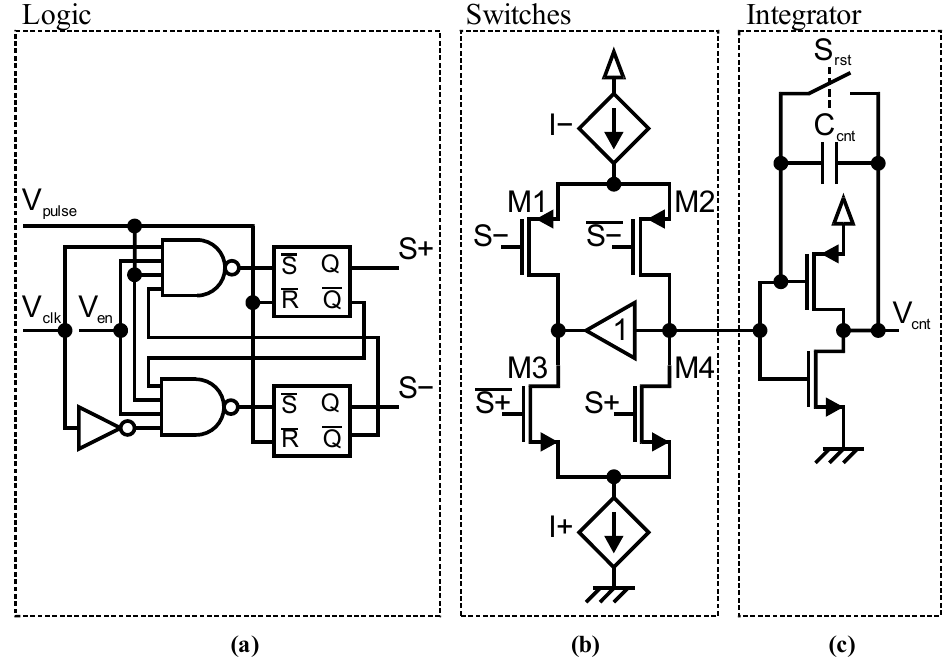
Figure 3. Analog correlator circuit consisting of ( a ) decision logic; ( b ) current steering switches; ( c ) integrator with reset.